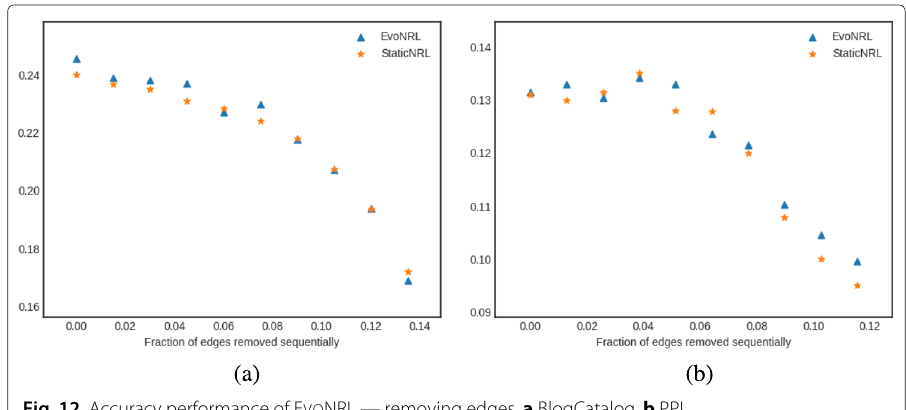
Fig. 12 Accuracy performance of E VO NRL — removing edges. a BlogCatalog, b PPI